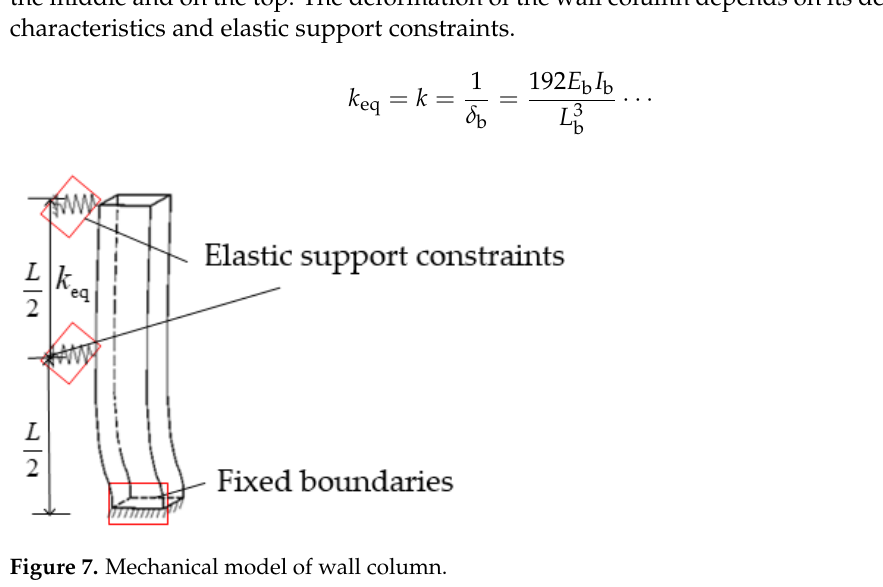
Figure 9. Basic structure of force method under uniformly distributed load of wall column. Because the deformation of the basic system is in the elastic stage, the internal forc- es of the basic system satisfy linear superposition, which means that the internal forces (axial force, shear force, and bending moment) can be expressed as the sum of the inter- nal forces of the loads X1, X2, and q acting alone, as shown in Equation (11). NqN1 N2N